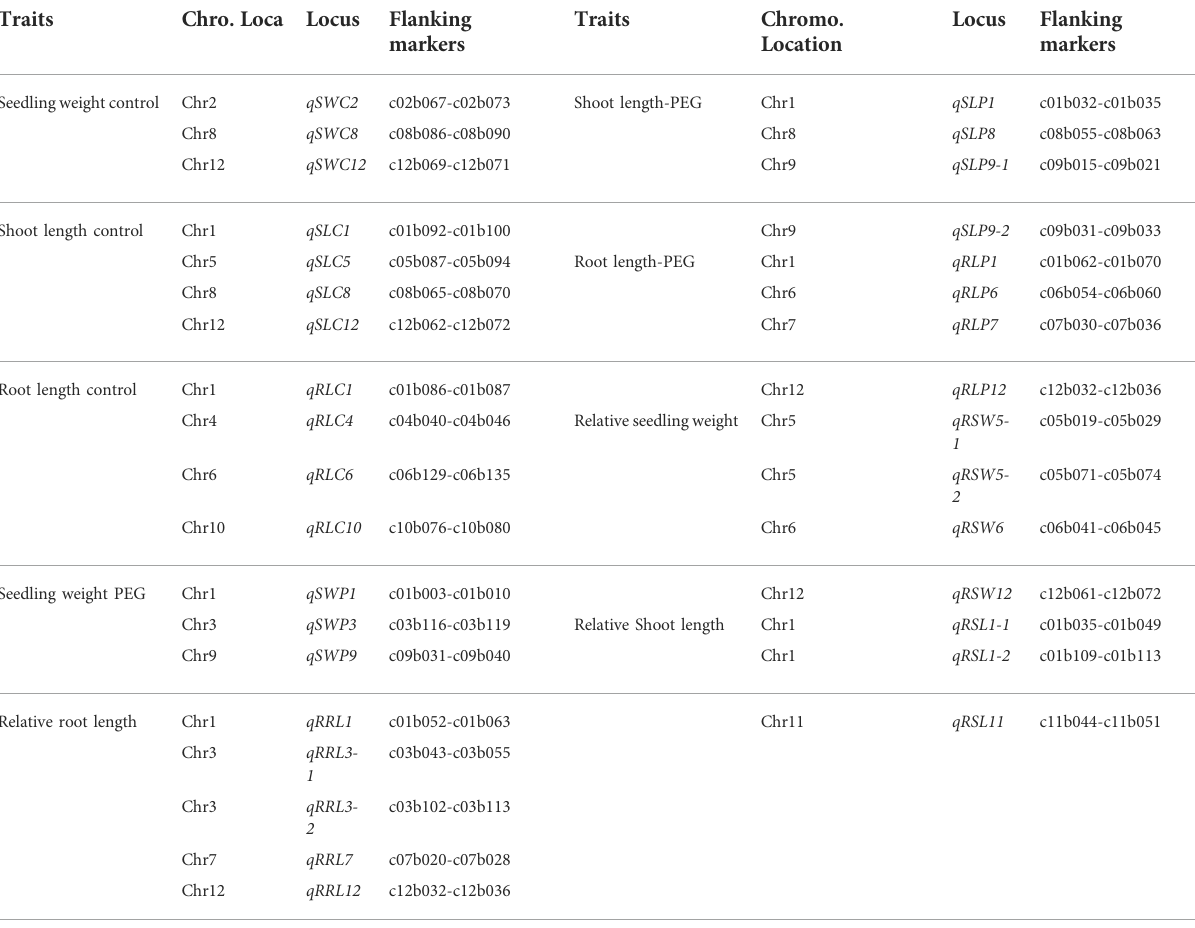
TABLE 9 Detailed information on drought tolerance traits and their QTLs.